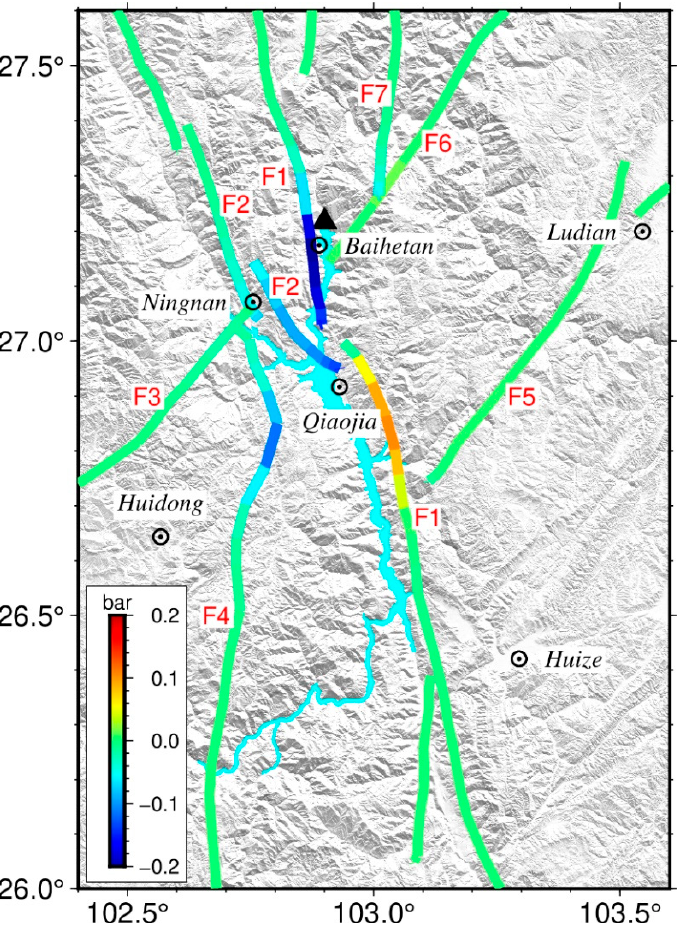
Figure 7. Coulomb stress variation on faults at 10 km underground caused by Baihetan reservoir impoundment. Abbreviations are the same as those in Figure 1a.